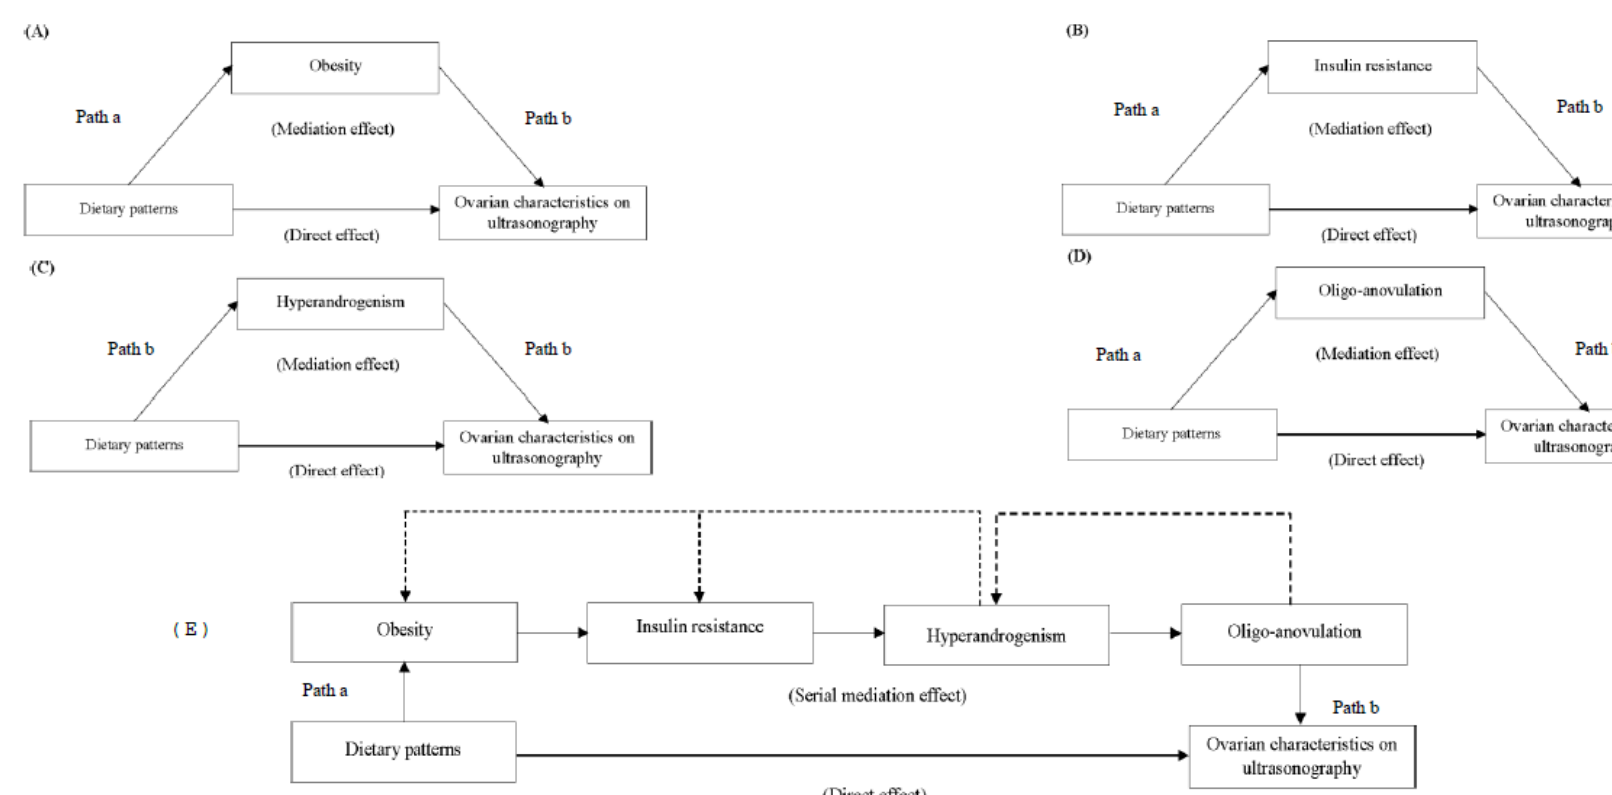
Figure 1. Regression modeling for direct and indirect mediation frameworks. The e ff ect estimates of dietary patterns on ovarian morphology without taking into account mediators is known as “direct e ff ect.” The e ff ect estimates of dietary patterns on ovarian morphology while controlling for an individual mediator were fitted ( Panels A to D ) to illustrate “simple mediation.” The “serial mediation model” fitted the association between dietary patterns and ovarian morphology while accounting for all mediators ( Panel E ). The sum of direct and indirect e ff ect estimates is known as “total e ff ect.” The solid lines were accounted for in the pathway analyses. The dotted lines illustrate the pathophysiologic associations between mediators and were not included in the pathway analyses as per the objective of the study. Abbreviations: X, exposure; M, mediator; and Y, outcome variables.